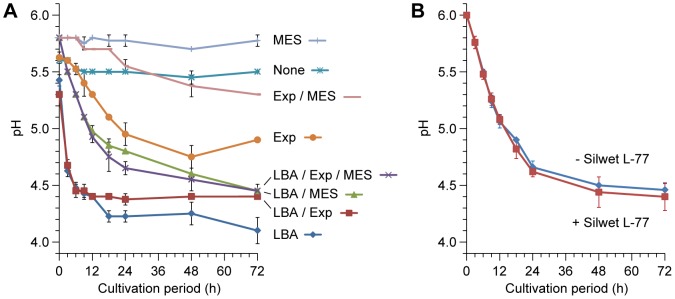
Changes in medium pH during co-cultivation.A. Effects of Agrobacterium strain LBA4404 harboring pSB111-GFP (LBA), cotyledonary node explants (Exp), and MES buffer (MES) on medium pH (n = 4). The co-cultivation media were initially adjusted to pH 5.8 and sterilized by filtration to circumvent the pH decrease caused by autoclaving. In the absence of MES buffer, pH values had already declined in the time it took to prepare the Agrobacterium suspension in co-cultivation medium (∼30 minutes). B. Changes in pH of MES-buffered medium initially adjusted to pH 6.1 (n = 5). The medium was sterilized by autoclaving and then used for co-cultivation of Agrobacterium and explants. The effect of Silwet L-77 treatment prior to co-cultivation was also examined. Data are the means ± SD. The pH of the medium was measured at 0, 3, 6, 9, 12, 18, 24, 48, and 72 hours after the initiation of cultivation.